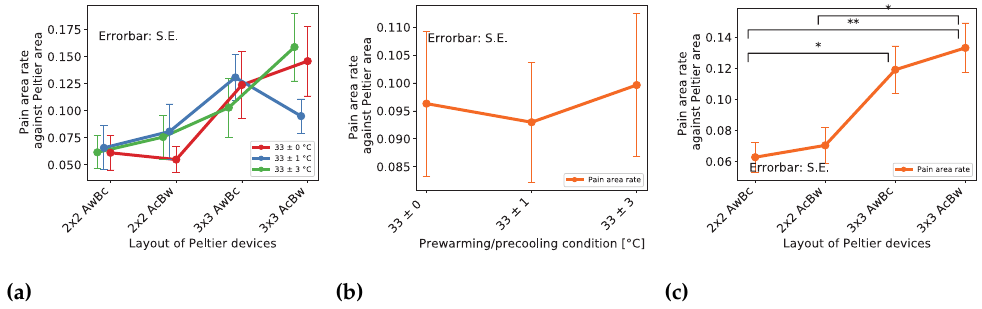
Figure 8. Area of the pain sensation result of spatial distribution effect. The * and ** indicates a significant difference of p < 0.05 and p < 0.01 for each. ( a ) Effect of layout of Peltier device and pre- cooling/pre-warming condition on pain area rate ( b ) Averaged effect of pre-cooling/pre-warming condition on pain area rate ( c ) Averaged effect of layout of Peltier device on pain area